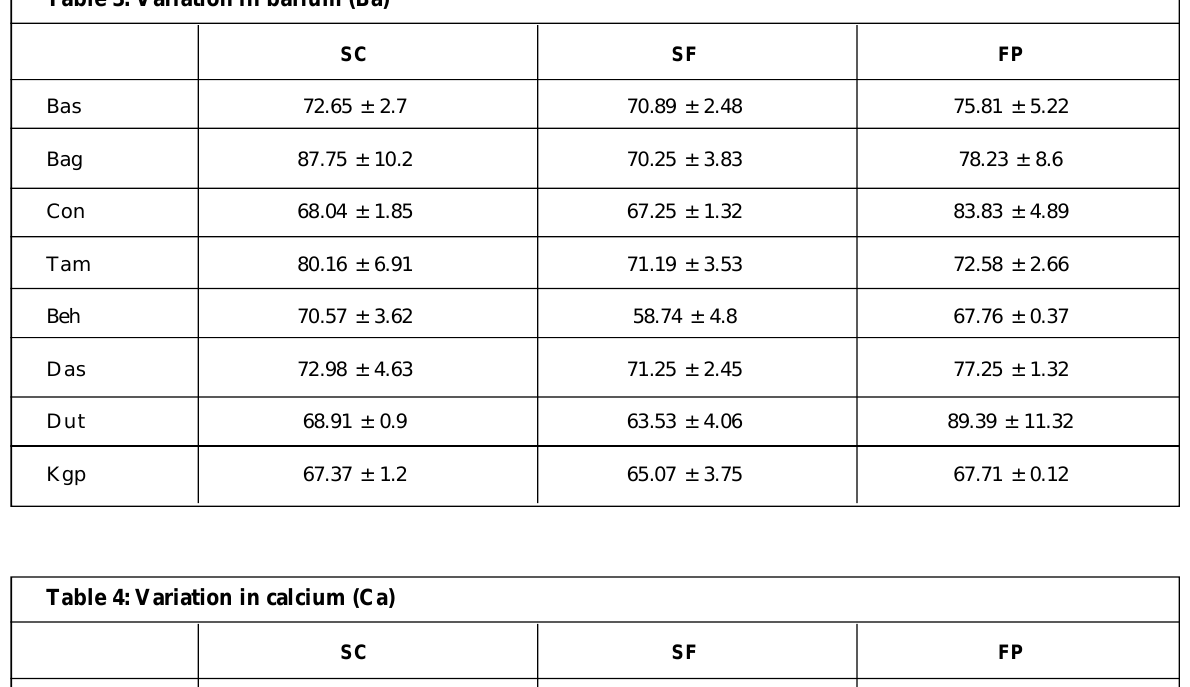
Table 3: Variation in barium (Ba)